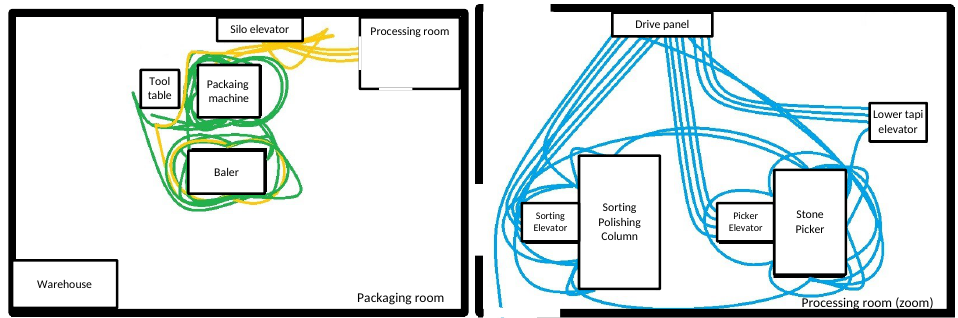
Figure 5. Spaghetti diagram of setup after cycle 1. Each color represents a different operator.